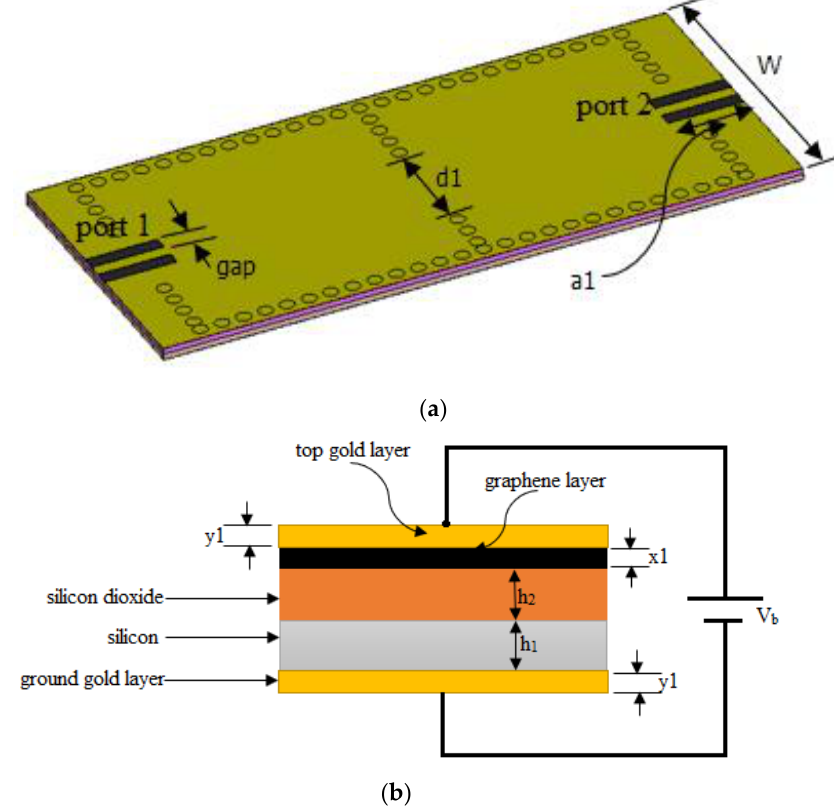
Figure 1. ( a ) Second-order SIW filter 3D image; ( b ) cross-sectional view. A band-pass filter was designed for operation at a resonant frequency of 1.2 THz. Figure 1b is the cross-sectional side view of the proposed filter. The top and ground plane were made up of gold of thickness 0.17 µm. A double layer of silicon (Si) and silicon di- oxide (Si0 2 ), with permittivity of 11.9 and 3.9, respectively, was also included. Graphene of thickness 0.0034 µm was placed between the Si0 2 substrate and the top gold plate. The applied external DC bias voltage is indicated as V b . The structure was simulated at first with no graphene, as shown in Figure 2. This graph shows the return loss and insertion loss of the filter device. The SIW filter parame- ters are given in Table 1. It can be seen that the filter operated at a frequency of 1.2902 THz with a return loss of −44 dB. The group delay is shown in Figure 3. It can be seen that a group delay of less than 1.15 ns occurred at the edge of the passband. From the results, we can see that the group delay was very small, which is desirable; otherwise, a higher group delay will distort the waveform of the signals, resulting in unreliable communica- tion. The surface current of the filter is shown in Figure 4. With the current being directly proportional to the electric field, this confirmed the electric field variations on the gra- phene patch, showing that the fundamental mode was being passed from port 1 to port 2 with a strong electric field on the surface of the graphene patch. Figure 5 shows the im- pedance plot of the filter, which confirms the resonance of several modes in the structure. The modes were quite close to each other and they could bring about a wider bandwidth band-pass filter if they could be merged together. Table 1. SIW filter parameters. Parameter